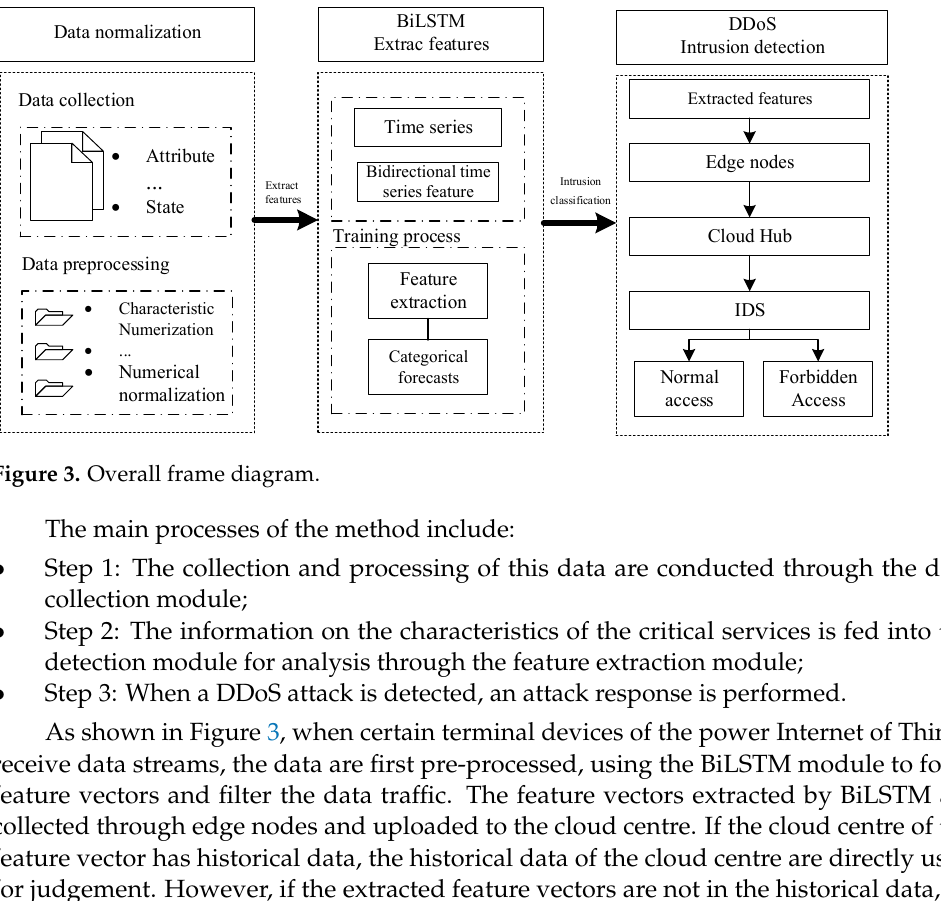
Figure 3. Overall frame diagram.